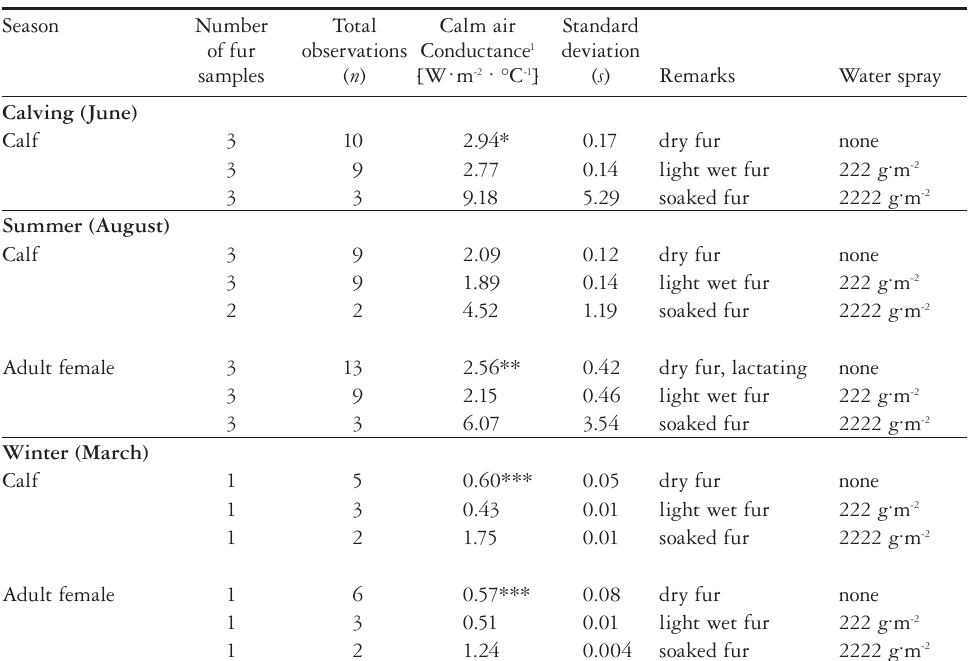
Table 1. Heat transfer through dry, light wet and soaked mid-back fur samples from Svalbard reindeer at zero wind velocity, with respect to age and season.